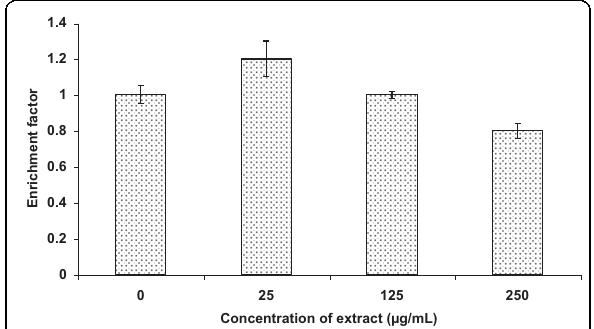
Figure 2 Effect of Spirulina extract on apoptotic cell death of 3T3 cells . The cells were incubated for 1 h before being assessed for apoptosis. Data presented as mean ± standard deviation (n = 3). The enrichment factors of the cells treated with extract were not significantly different (p > 0.05) from the